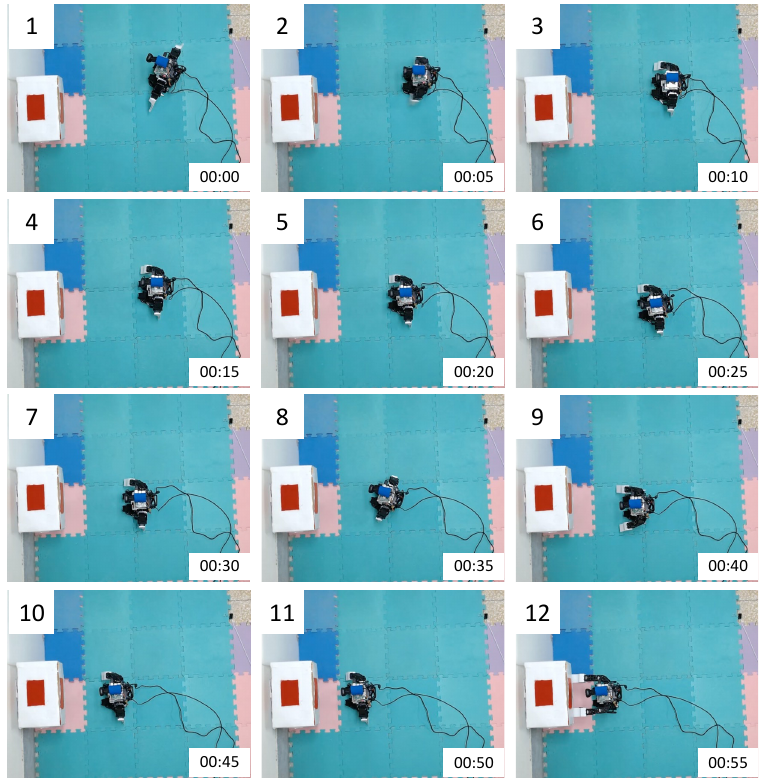
Figure 7. Experimental results of one HR with fuzzy technique.